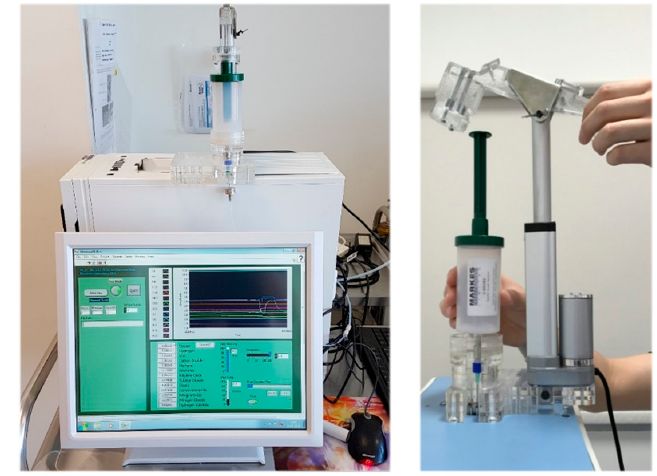
Figure 2. Wolf eNose and custom Bio-VOC injection system.